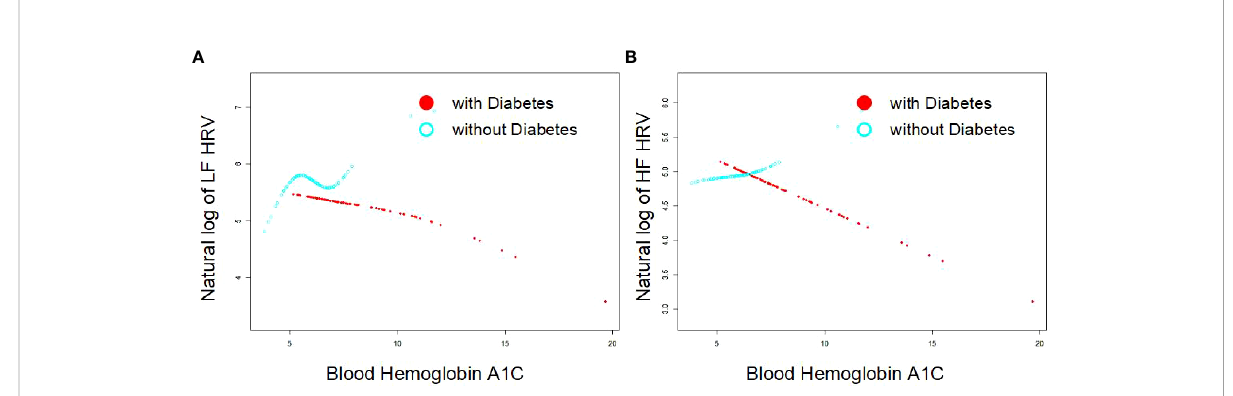
FIGURE 2 Corrected smooth curve for the association between blood HbA1c and HRV [As (A, B) indicates, the corrected smooth curve suggested inverse relationships between blood HbA1c levels and HF-HRV and LF-HRV values in participants with DM (P<0.05) but not in those without DM (P>0.05)after controlling for all covariates, including age, sex, BMI, smoking, number of drinking years and exercise].